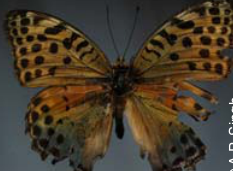
Image 74. Staff Sergeant, Athyma cama (upper)